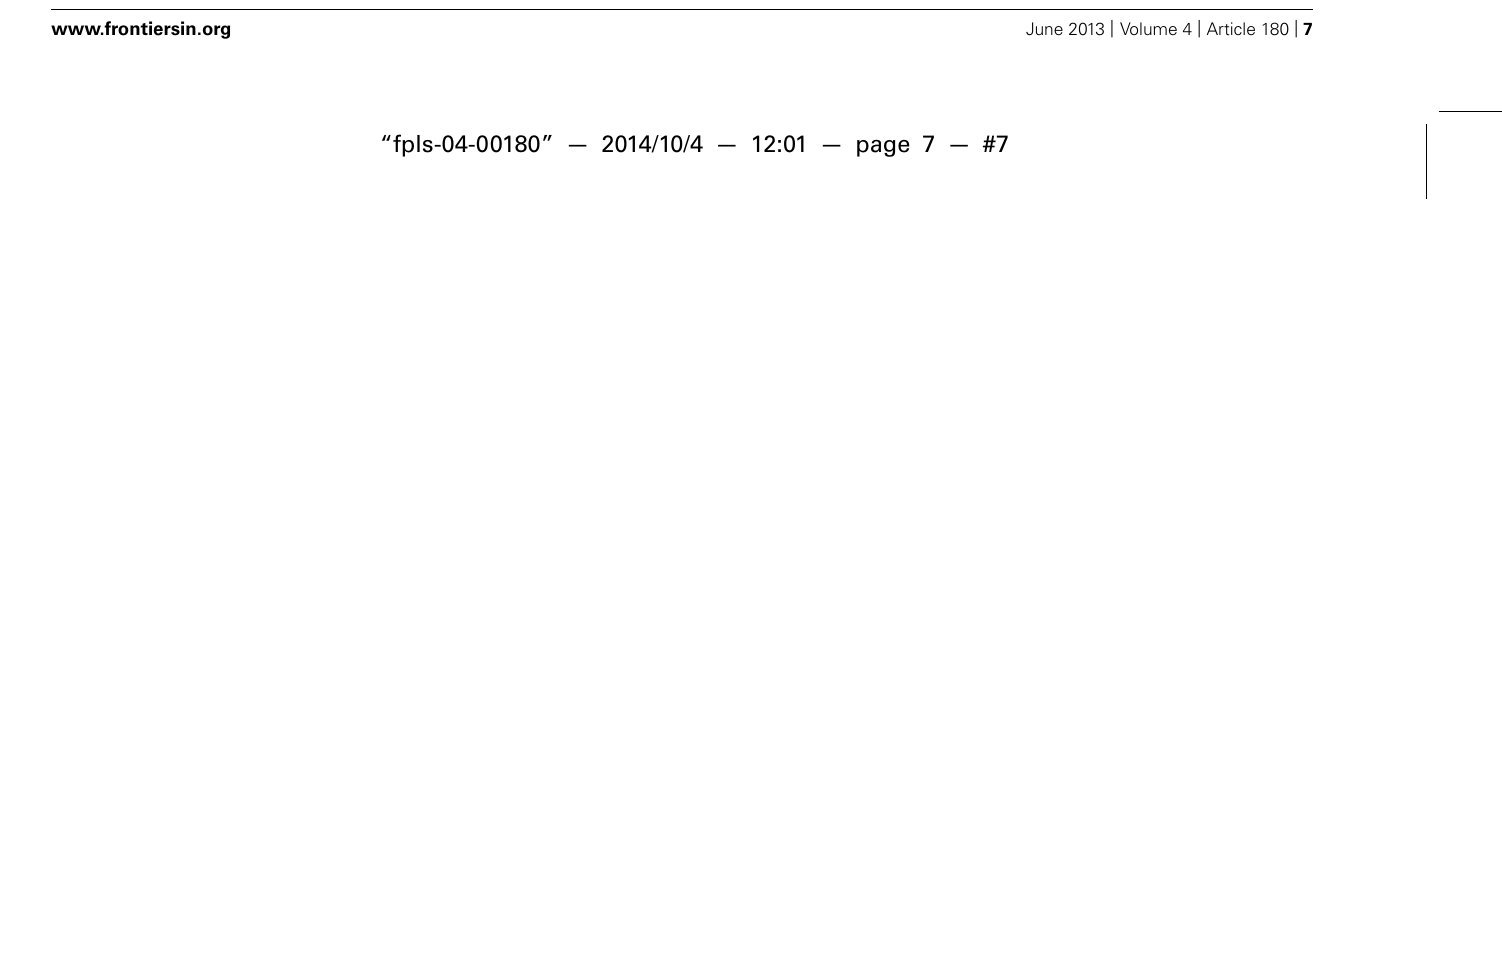
concentrations were 2 and 100 μ M of ZnSO 4 (Zn2, Zn100). Cd treatment concentrations were either no exposure (Cd0) or 5 and 10 μ M of CdSO 4 to G. elegans and G. claussenii , respectively (high Cd). Plants were grown for 3 weeks on control solution (2 μ M Zn) before 3 weeks of treatments exposure.